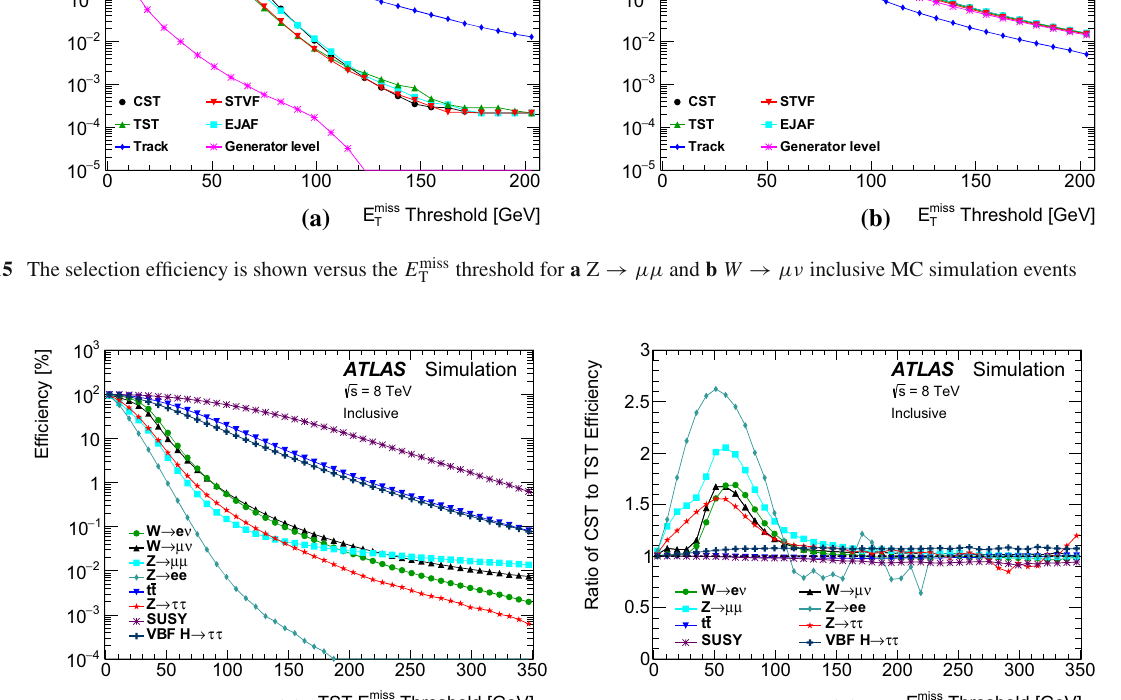
versus the E miss threshold and b the ratio of CST to TST efficiencies versus E miss T T